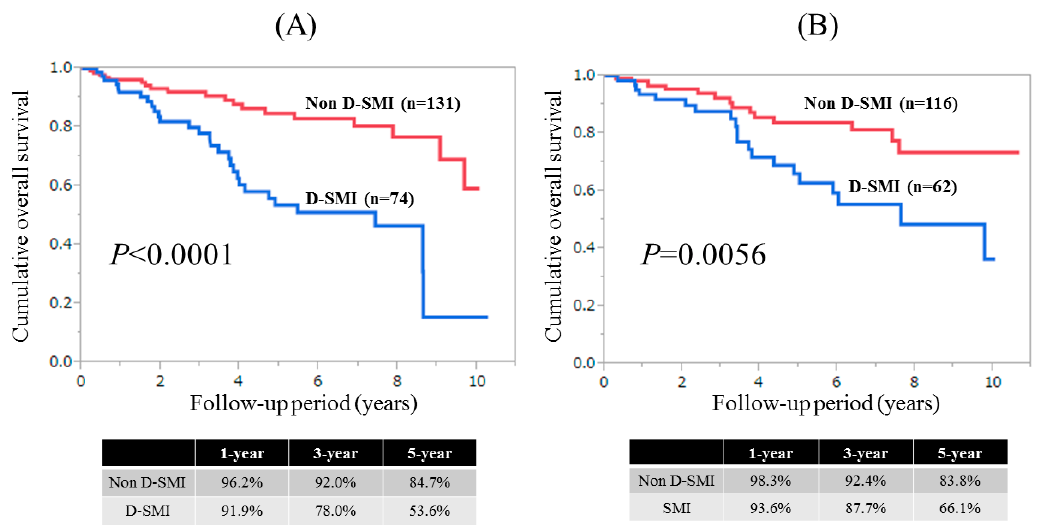
Figure 3. Cumulative overall survival for males ( A ) n = 205 and for females ( B ) n = 178 in patients with and without D-SMI. SMI: skeletal muscle mass index; D-SMI: decreased SMI.